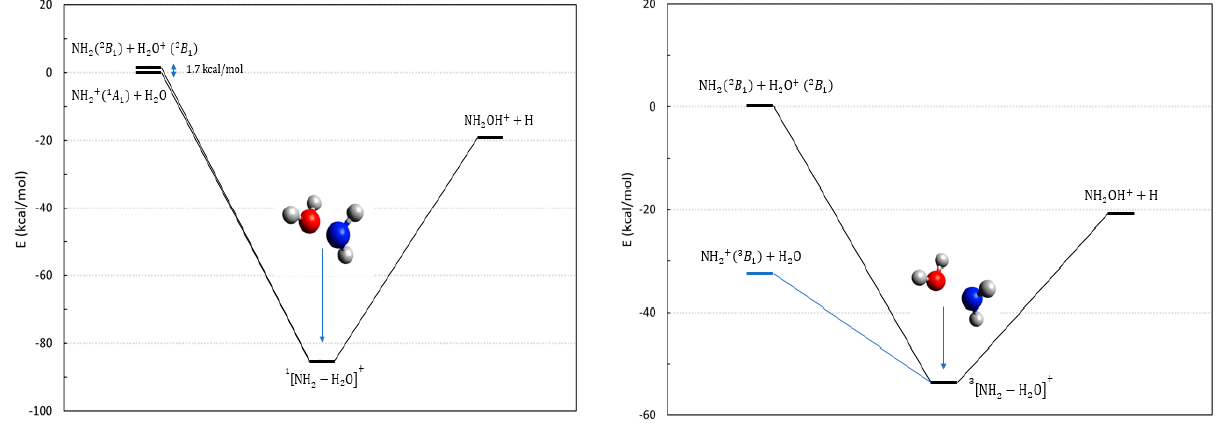
Figure 3. Energetic scheme of the possible entrance and exit channel of reactions 5 and 6 involving the system [ NH 2 − H 2 O ] + with singlet ( left ) and triplet ( right ) multiplicity. The blue line in the right panel is the ground state entrance channel. Energies computed at CCSD(T)/Def2-TZVPP level.